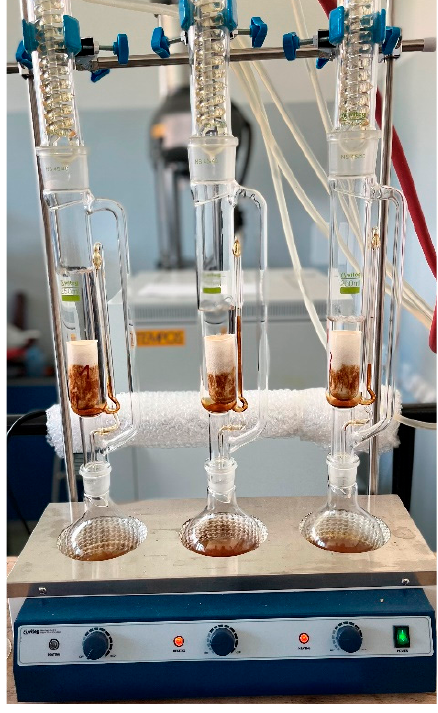
Figure 1. Soxhlet apparatus.